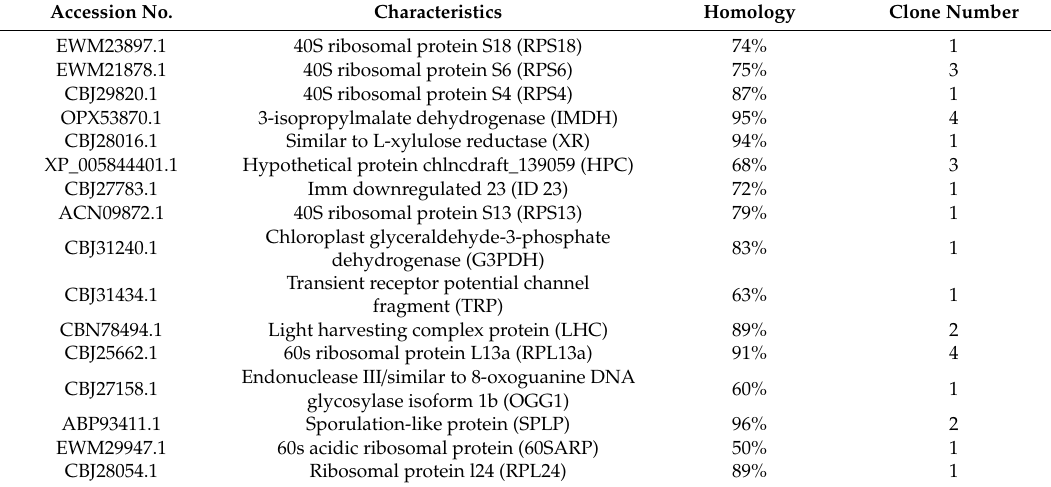
Table 3. BLAST analysis of yeast two-hybrid results using SjAUREO as bait to screen the BL treated cDNA library.